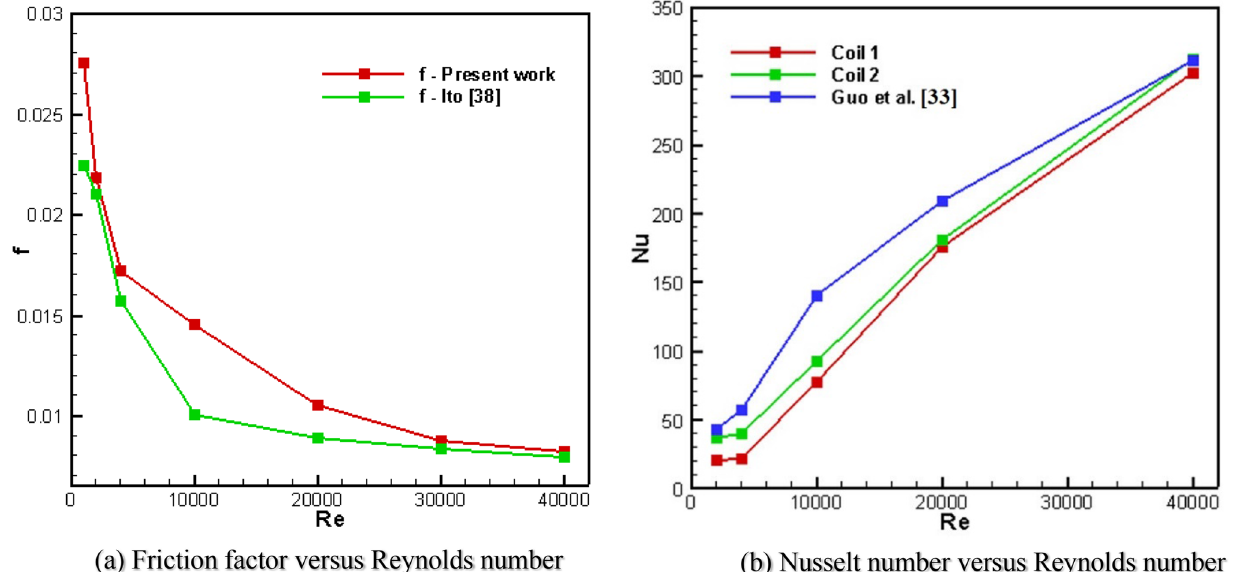
Fig. 11 Coils pitch investigation. a indicates the Reynolds number versus f comparison between the Coil No.1 and No.2 with Ito [38]. b indi- cates the Reynolds number versus Nusselt number comparison between the Coil No.1 and No.2 with Guo et al.